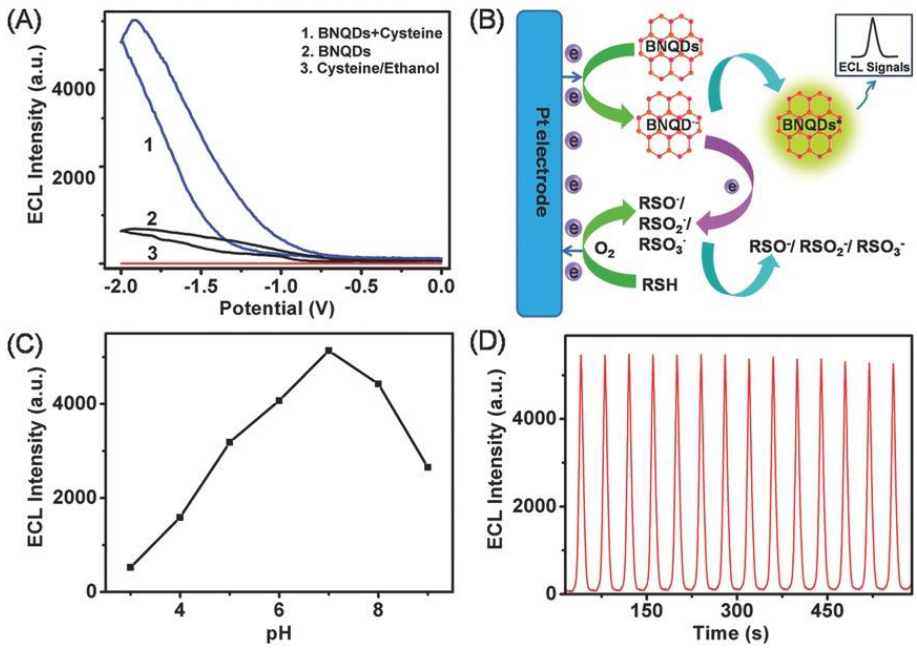
Figure 13. ( A ) Electrochemiluminescence (ECL) intensity–potential curves of 100 mg mL −1 BNQDs prepared in ethanol in 100 × 10 −3 m PBS (pH 7.0) with varying condition. ( B ) Schematic illustration of the ECL mechanism of the BNQDs/L-cysteine (RSH) system. ( C ) Influences of buffer pH on the ECL intensity of 100 mg mL −1 BNQDs. ( D ) ECL intensity–time curve under continuous cyclic voltammetry scanning between −2.0 and 0 V for 600 s for the BNQDs/RSH system. The scan rate is 100 mV s −1 . Reproduced from [40] with permission from 2016 Wiley-VCH Verlag GmbH & Co. KGaA (Weinheim, Germany).